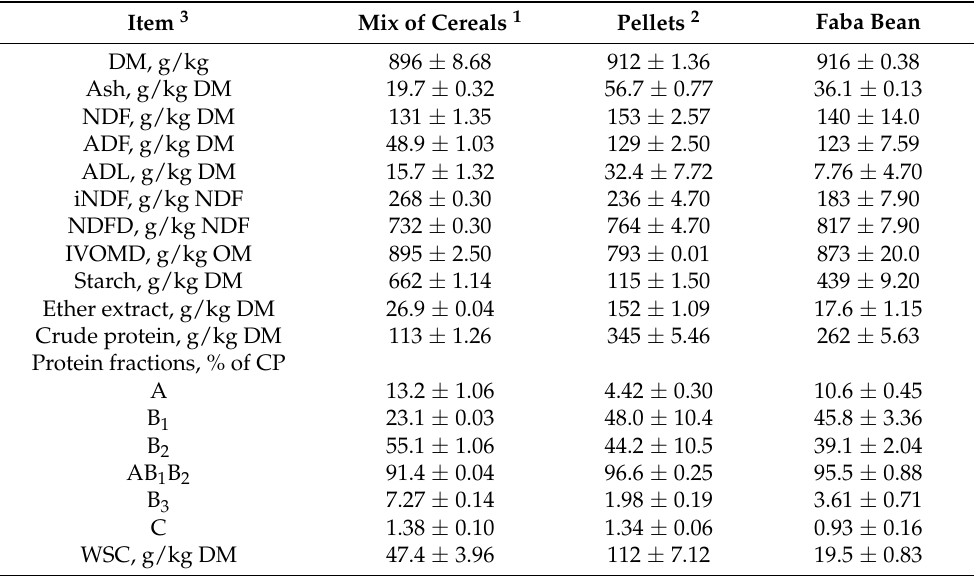
Table A1. Chemical composition (mean ± SD) of the concentrate ingredients ( n =